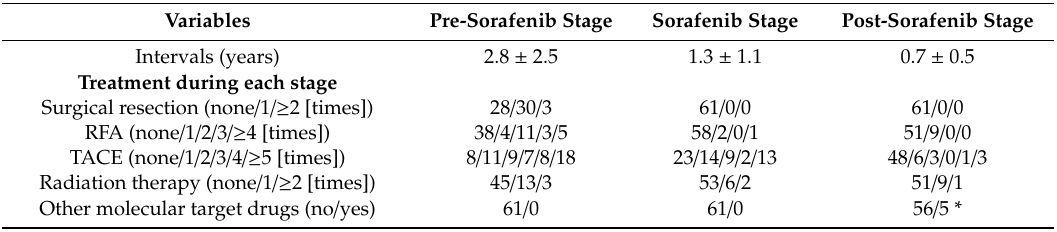
Table 2. Detailed treatment results during the pre-sorafenib, sorafenib, and post-sorafenib stages.